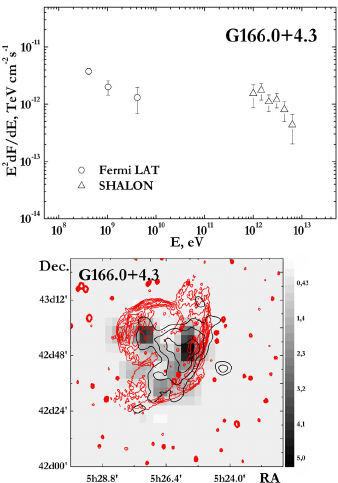
visible in radio energies by CGPS (red contours in Fig.3).